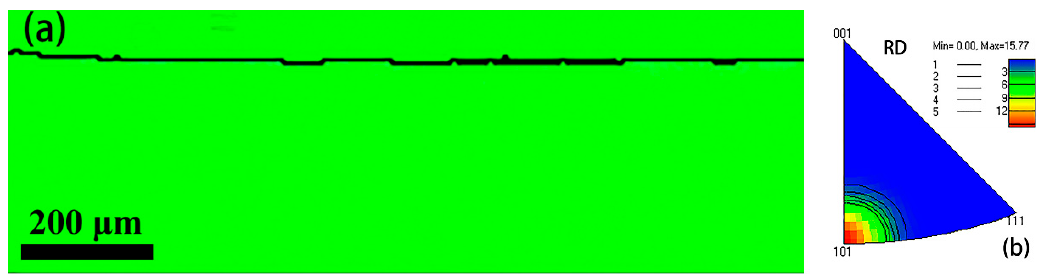
Figure 6. Microstructures of the center samples at the critical strain of the serrated flow behavior. ( a ) EBSD orientation map at 350 °C; ( b ) inverse pole figure.